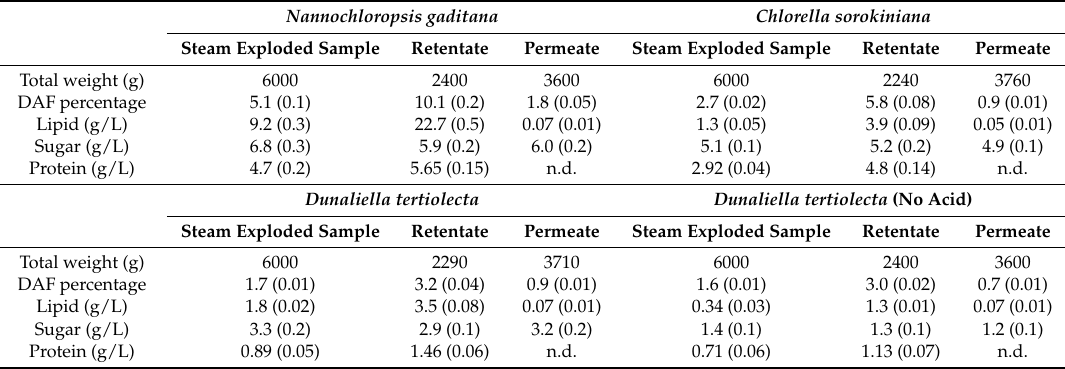
Table 2. Results of total mass balance, and lipid, sugar, and protein analysis of filtration experiments.